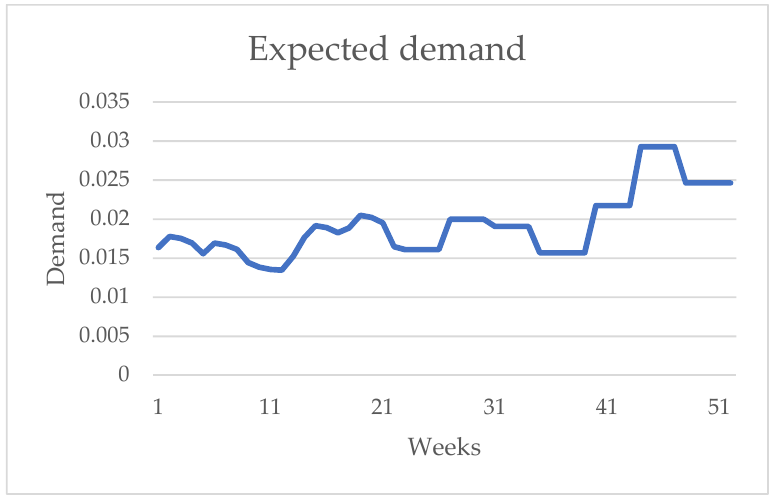
Figure 6. Weekly forecast of the expected demand.